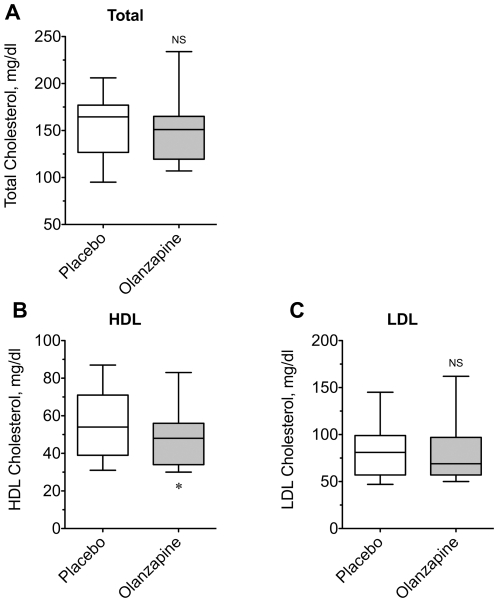
Effect of olanzapine on plasma cholesterol.Plasma concentrations of (A) Total cholesterol, (B) High-density lipoprotein, and (C) Low-density lipoprotein cholesterol were measured for all subjects under placebo- and olanzapine-treated conditions. Data are expressed as box plots for comparison of placebo and olanzapine-treated groups. An asterisk indicates (P = 0.018) a significant difference between the medians of the placebo and olanzapine groups. NS = not significantly different (n = 15).